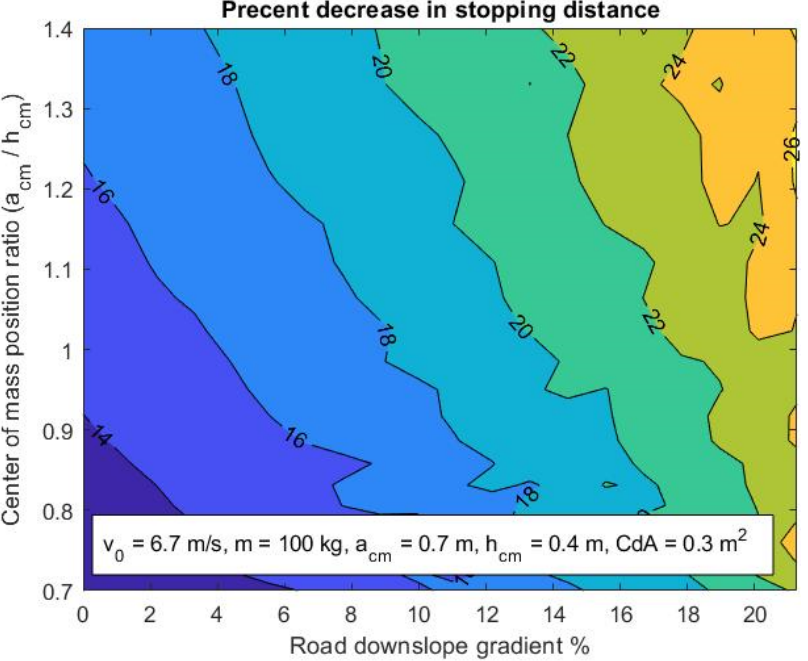
Figure 14. Percent decrease in stopping distance for the prototype brake system showing an increased advantage for high centers of mass and when riding on steeper downslopes.